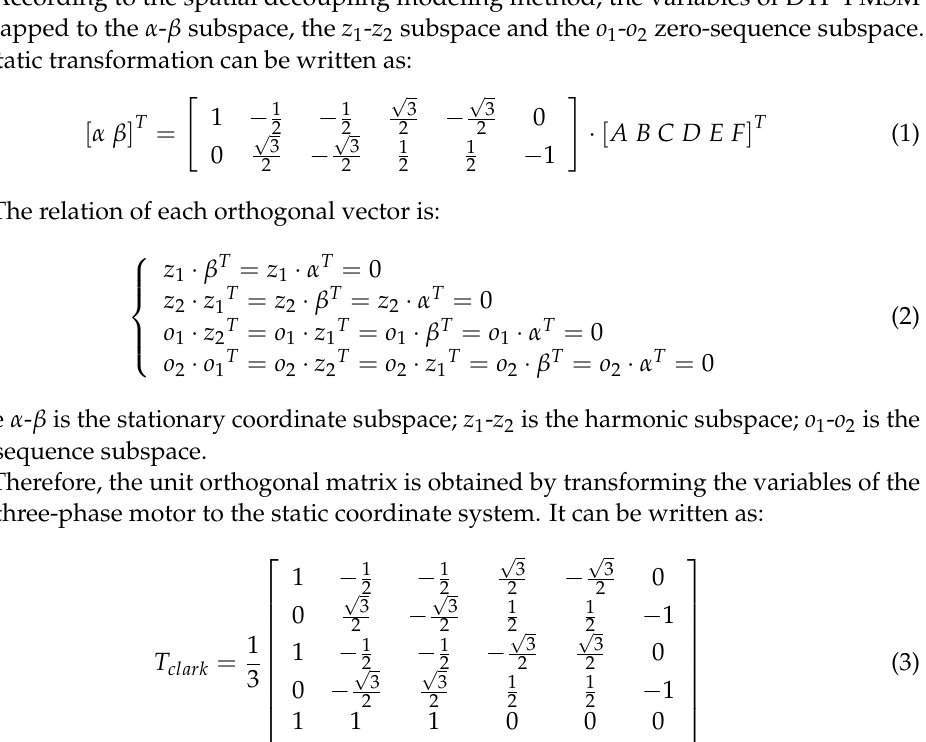
Figure 2. Neutral line connection mode of DTP-PMSM drive system. ( a ) Structure 1. ( b ) Structure 2. According to the spatial decoupling modeling method, the variables of